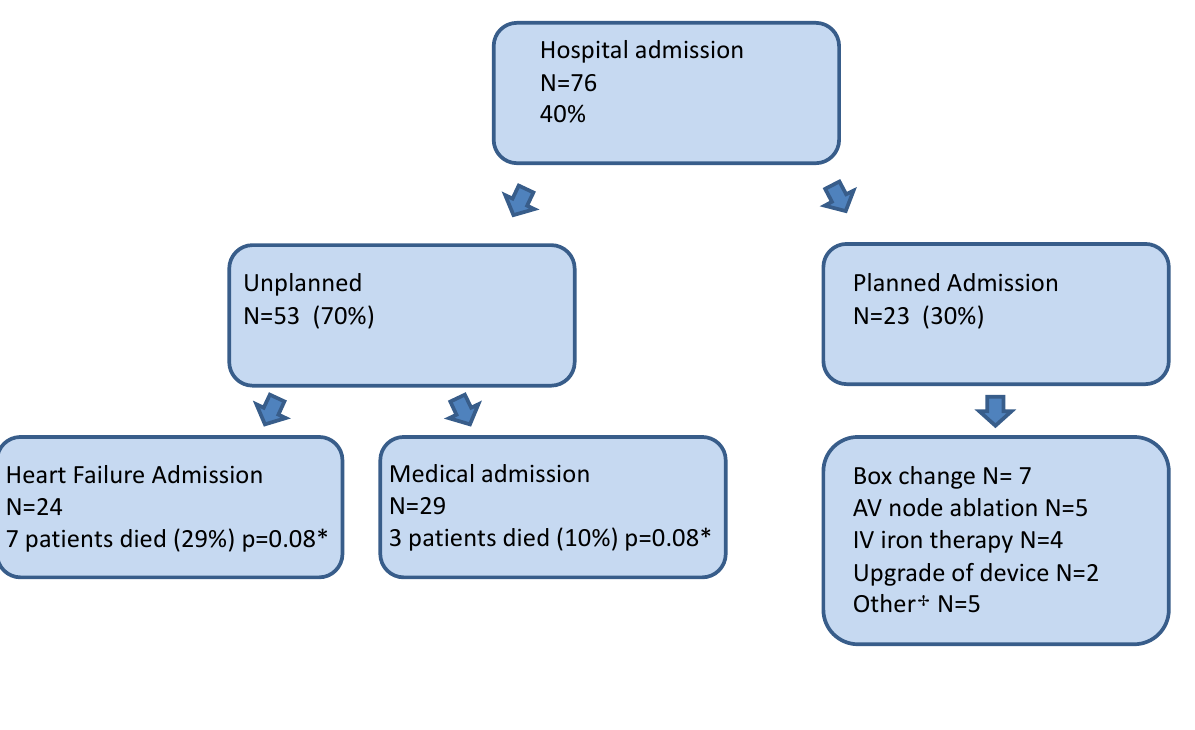
Figure 2. Flow chart of patient outcomes during study period.